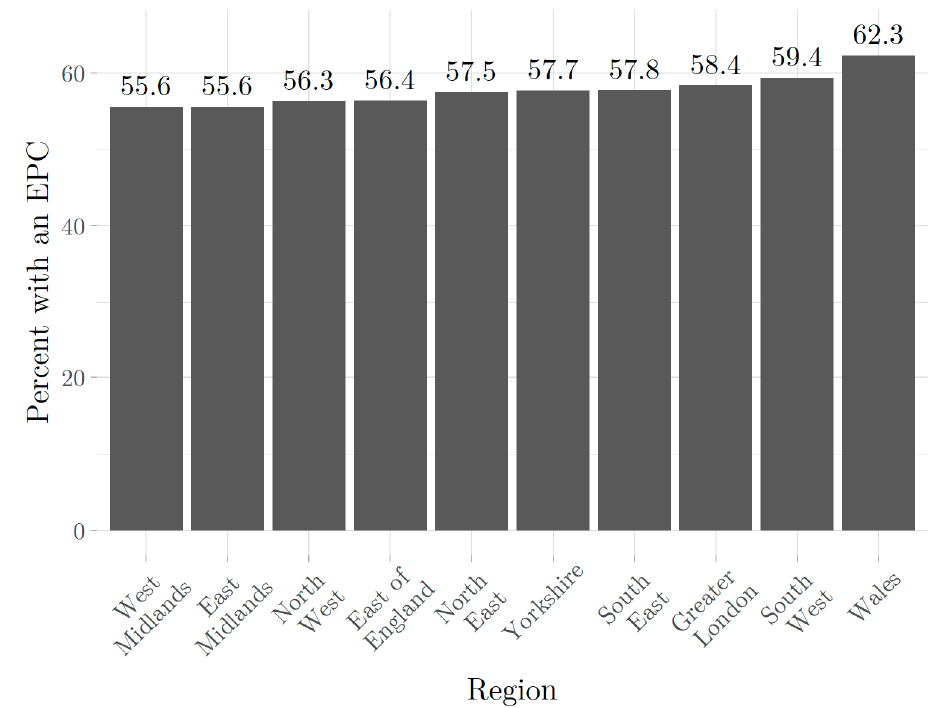
Figure A2 . Prevalence of EPCs among SERL Observatory households by region. Figure A2. Prevalence of EPCs among SERL Observatory households by